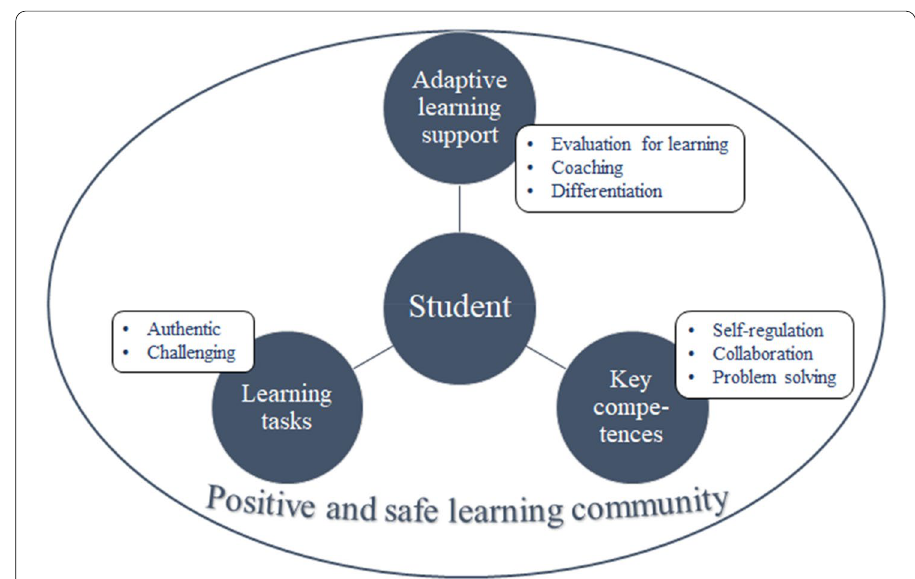
Fig. 1 Model of powerful learning environments in vocational education (adapted from Placklé et al. 2014, p. 111; 2018, p. 28; 2020, p.